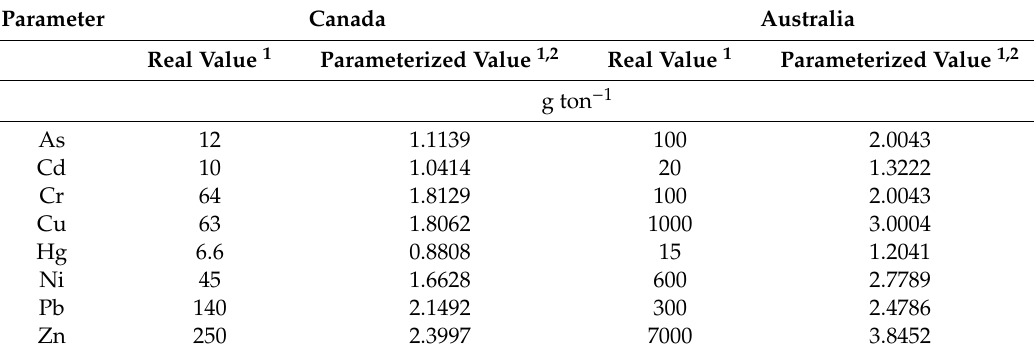
Table 1. Canadian [26] and Australian [27] soil quality reference